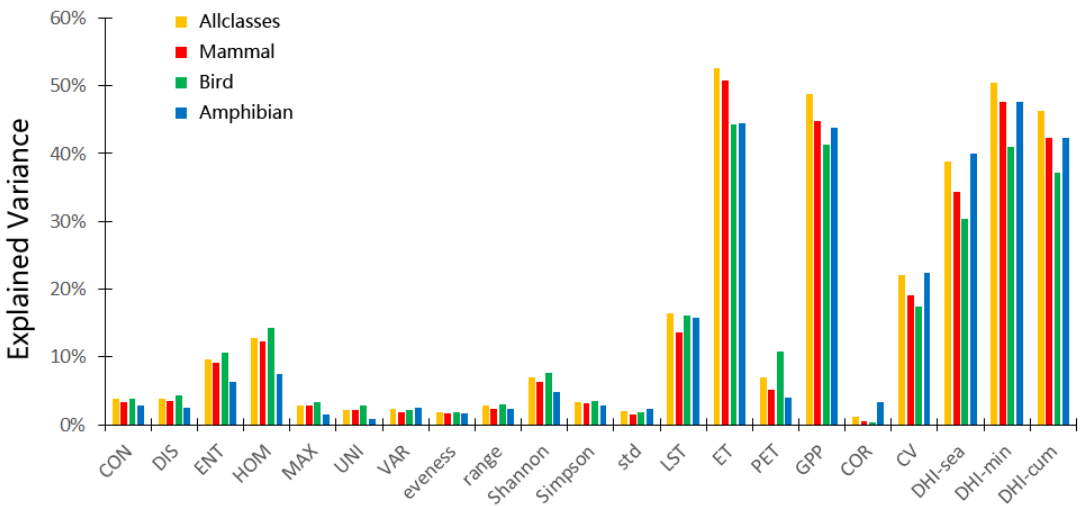
Figure 3. The explained variance of remote sensing metrics on species richness. Percentages of variance explained by the regression model was built with different remote sensing metrics. For DHI-min and DHI-cum, univariate linear regression was used to calculate the explained variance. For COR, CV, and DHI-sea, linearization was achieved by taking the log of the data before using univariate linear regression to calculate the explained variance. For the other metrics, polynomial regression was used to calculate the explained variance. Allclasses is the sum of mammal richness, bird richness, and amphibian richness, which was normalized. The measured values were obtained for 10,000 0.1-degree pixels randomly selected from global terrestrial areas. The full names of abbreviations can be found in the Table 1.